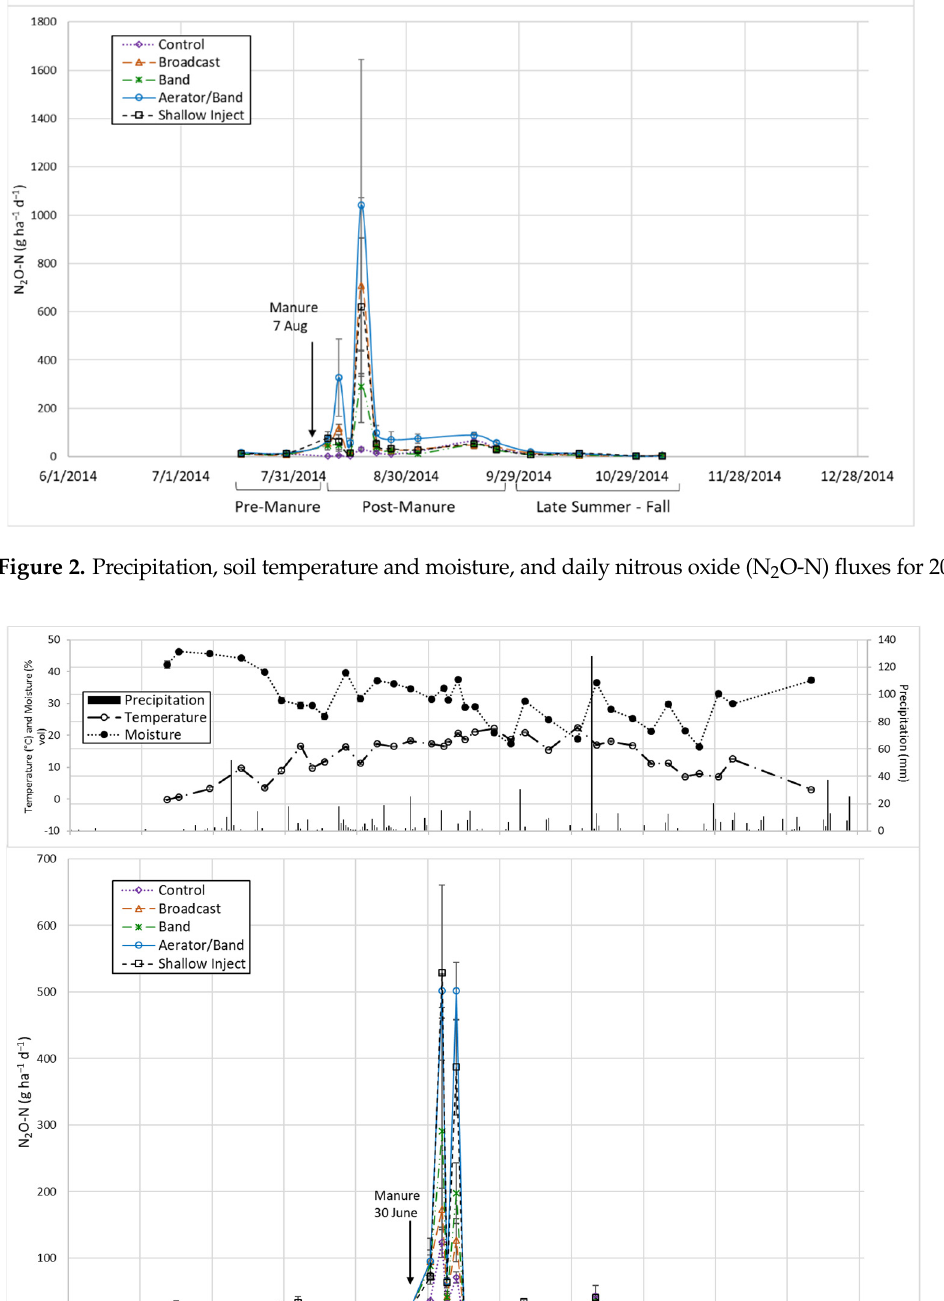
Figure 3. Precipitation, soil temperature and moisture, and daily nitrous oxide (N 2 O-N) fluxes for 2015.